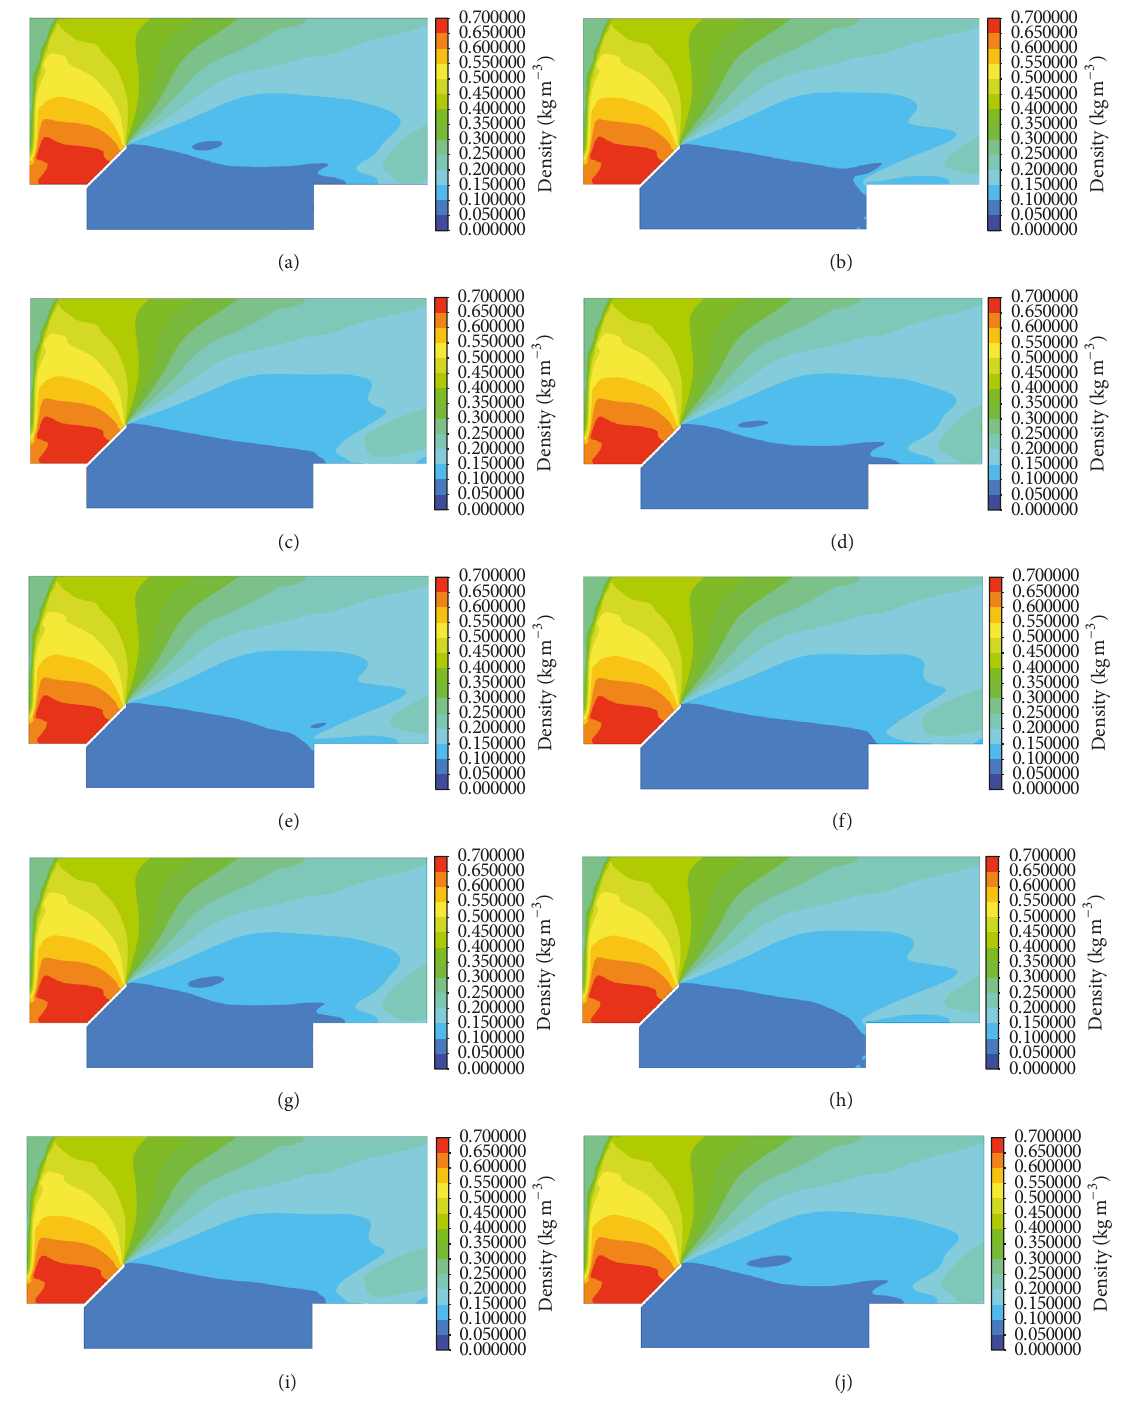
Figure 15: Density contours for CP4 case (a) 𝑡/𝑡 𝑅 = 0 , (b) 𝑡/𝑡 𝑅 = 0.11 , (c) 𝑡/𝑡 𝑅 = 0.22 , (d) 𝑡/𝑡 𝑅 = 0.33 , (e) 𝑡/𝑡 𝑅 = 0.44 , (f) 𝑡/𝑡 𝑅 = 0.55 , (g) 𝑡/𝑡 = 0.66 , (h) 𝑡/𝑡 = 0.77 , (i) 𝑡/𝑡 = 0.88 , and (j) 𝑡/𝑡 = 1 . 𝑅 𝑅 𝑅 𝑅